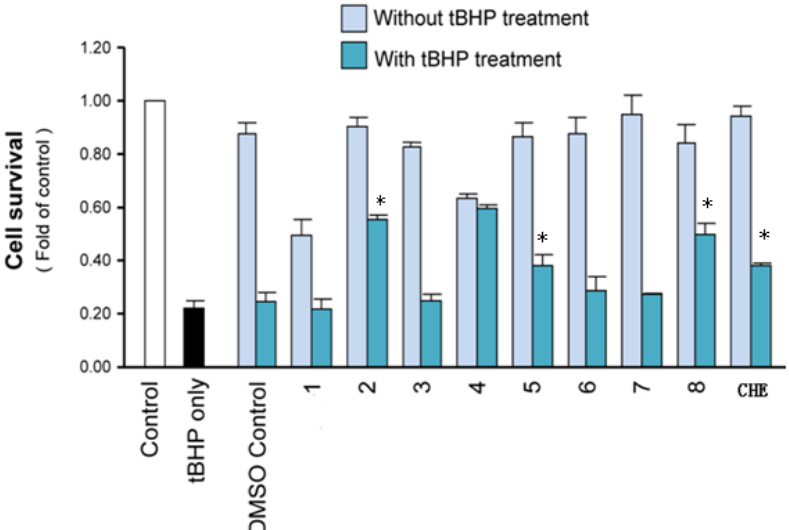
Figure 3. Protective effects of compounds and GHE on PC12 cells exposed to